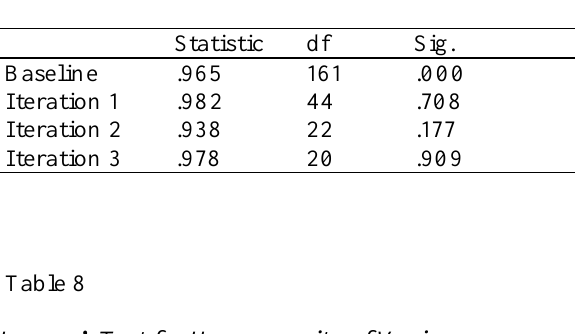
Levene’s Test for Homogeneity of Variances